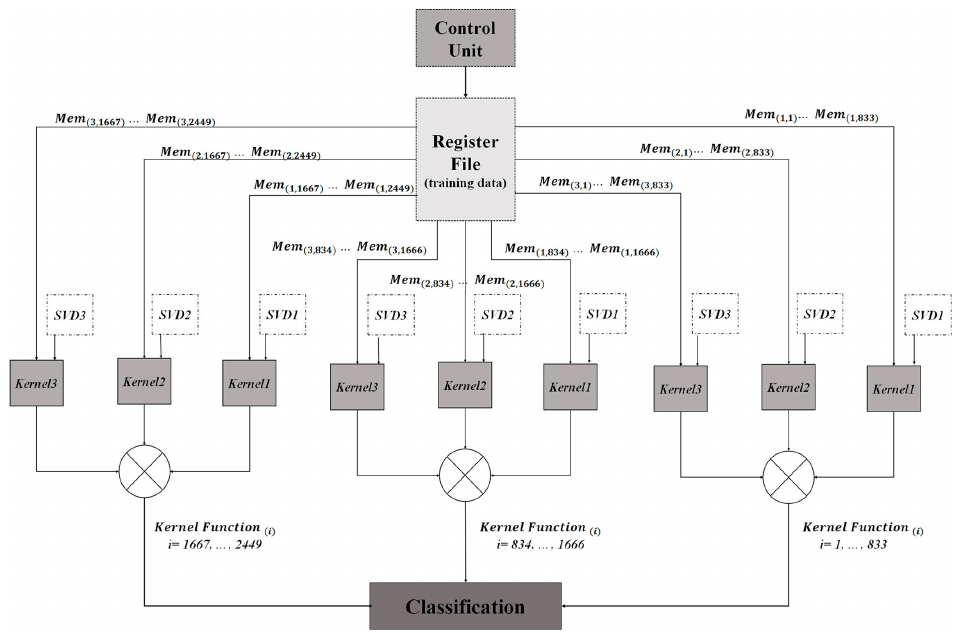
Table 4. Requirements for real-time classification of input touch modalities.